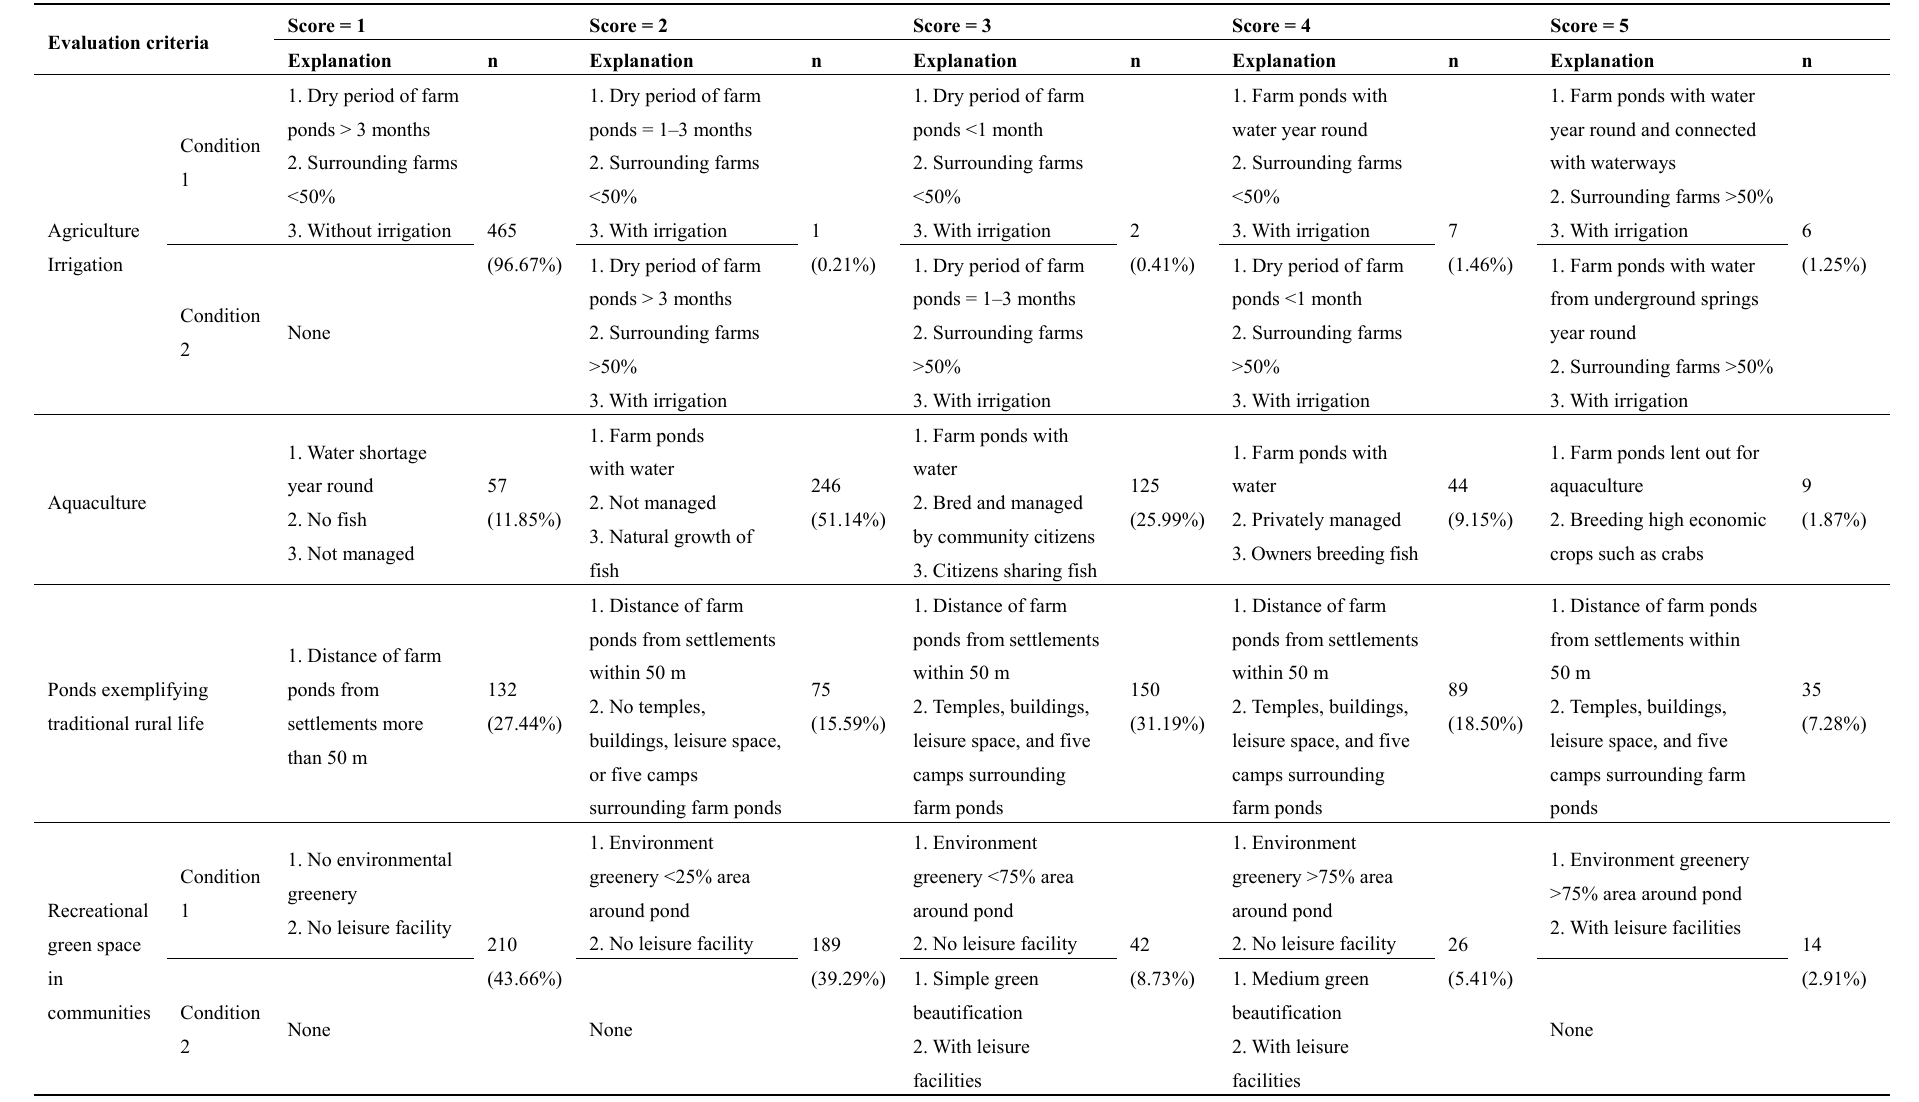
Table 2. Evolution criteria of farm pond